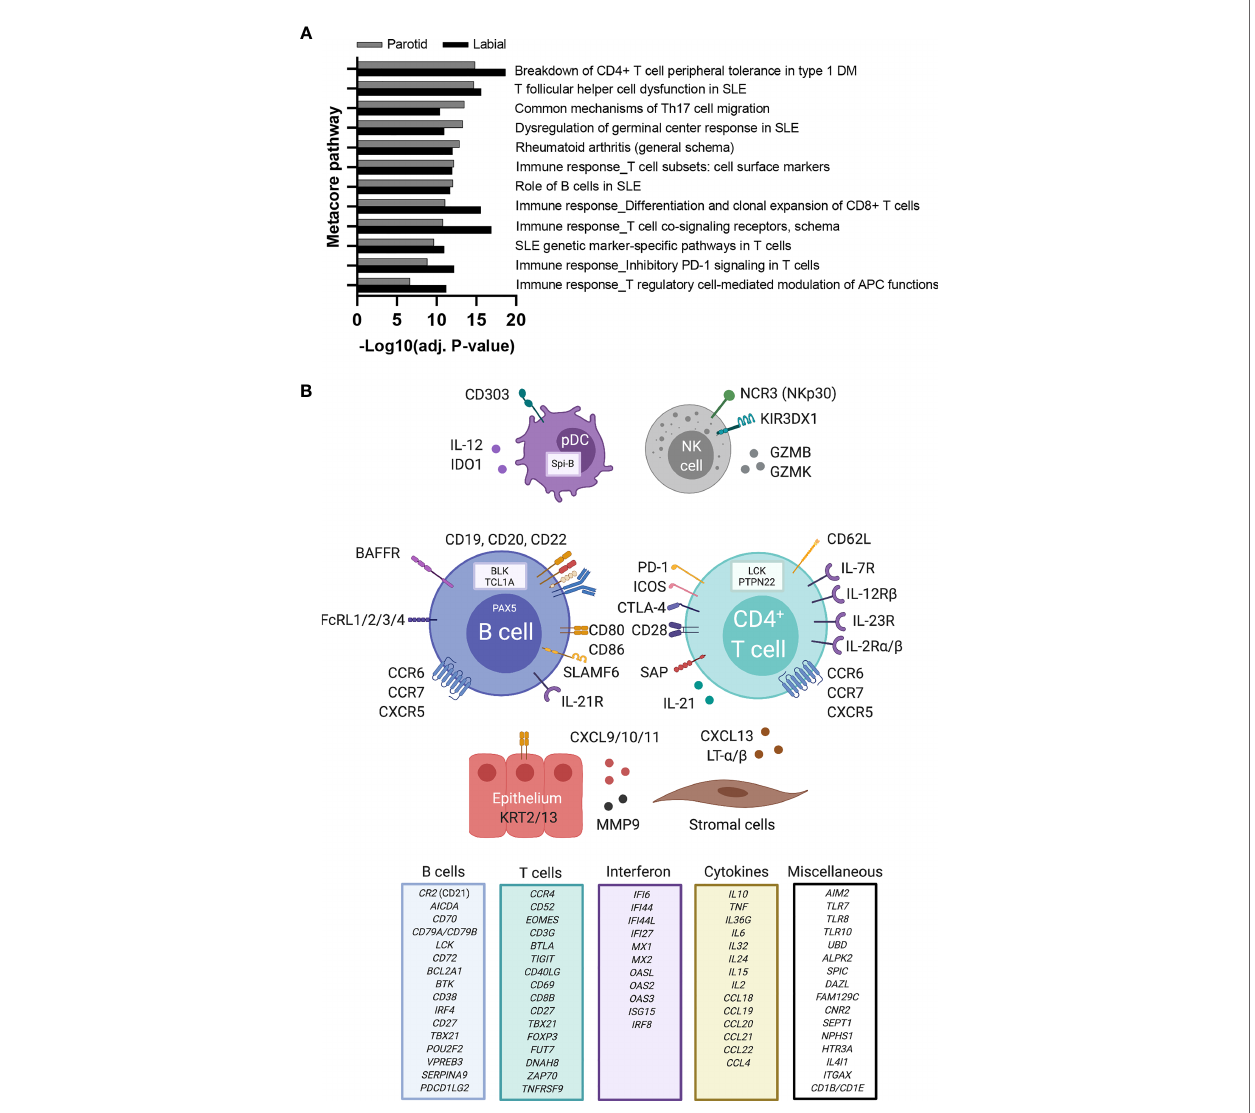
FIGURE 2 | Upregulated immune pathways and immune-related genes in labial and parotid gland tissue of primary SS patients. (A) Metacore pathway analysis of differentially expressed genes (DEGs) between biopsy-positive primary SS and biopsy-negative non-SS sicca patients. A separate pathway analysis was performed for labial and parotid gland tissue. Only the top (auto)immune-related pathways that were enriched in both glands are shown (FDR<0.05). Enrichment values provided by Metacore are displayed as − Log(adj.p) for parotid gland tissue (grey bars) and labial gland tissue (white bars). (B) DEGs upregulated in salivary gland tissue of biopsy-positive pSS patients are depicted in association with their predicted cell of origin. Other DEGs with known immune function were categorized and are listed in separate boxes. Created with